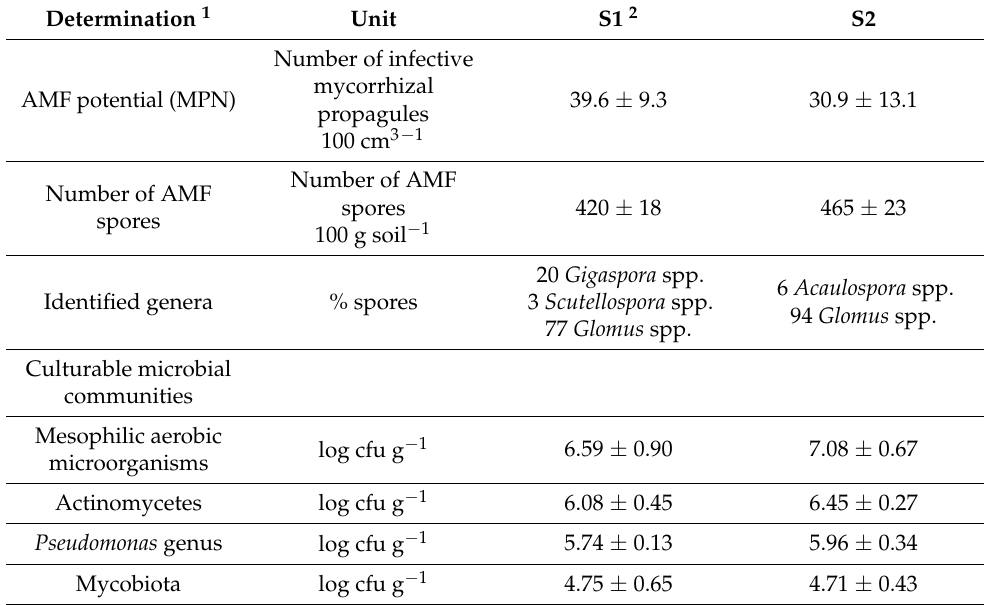
Table 1. AMF infective potential and microbiological composition of soils.